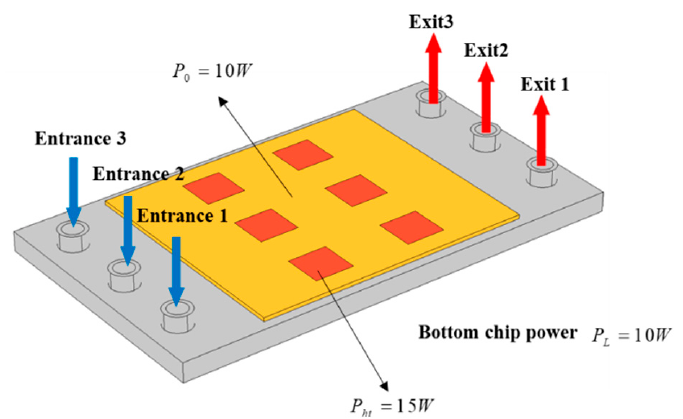
Figure 2. Schematic diagram of 3D model.